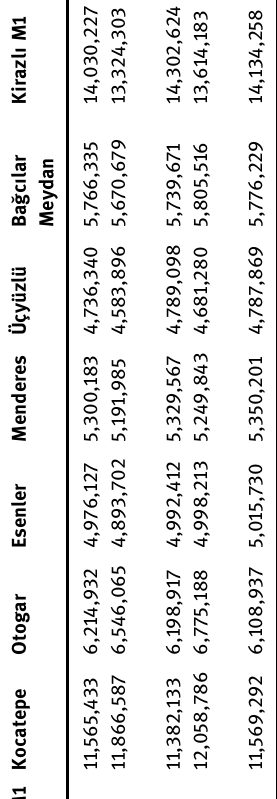
Table 8: Station basis comparison of actual data and ANNs outputs Stations Actual values Forecasting values of ANNs